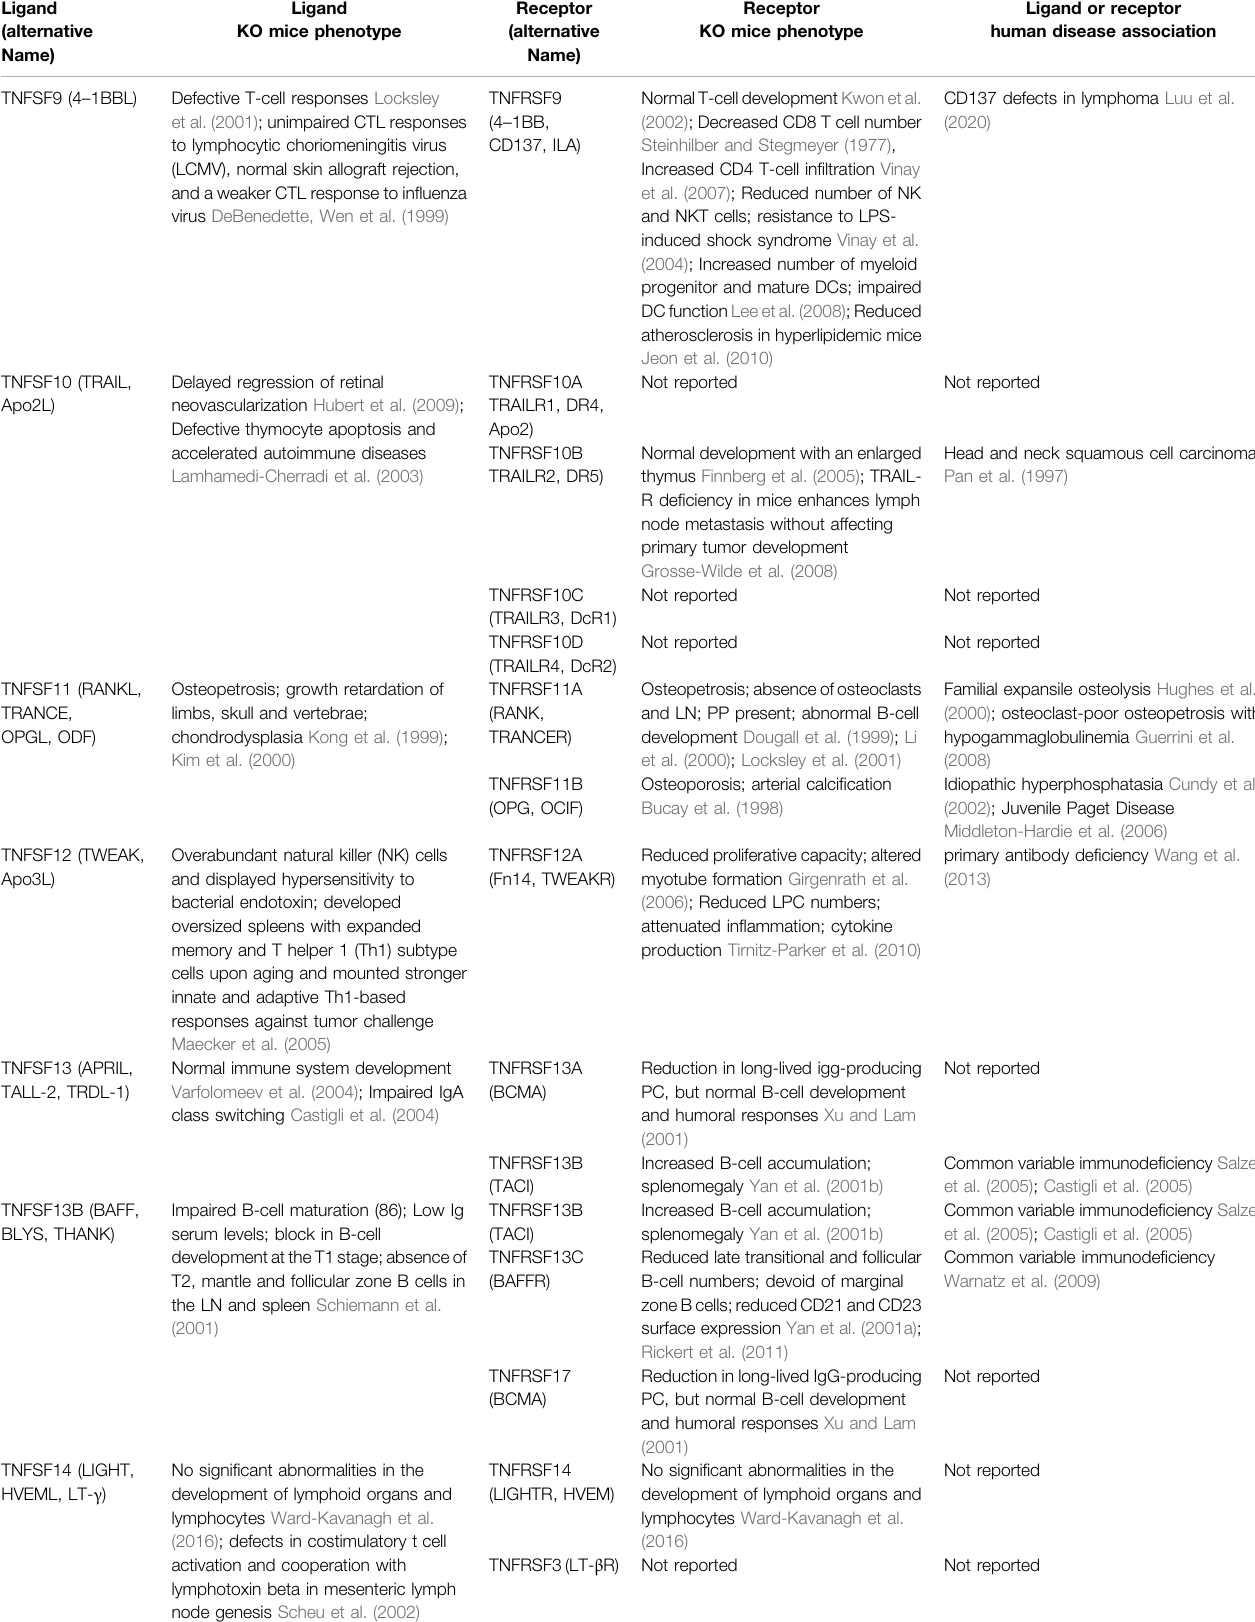
TABLE 1 | ( Continued ) Tumor necrosis factor superfamily ligands and receptors and their